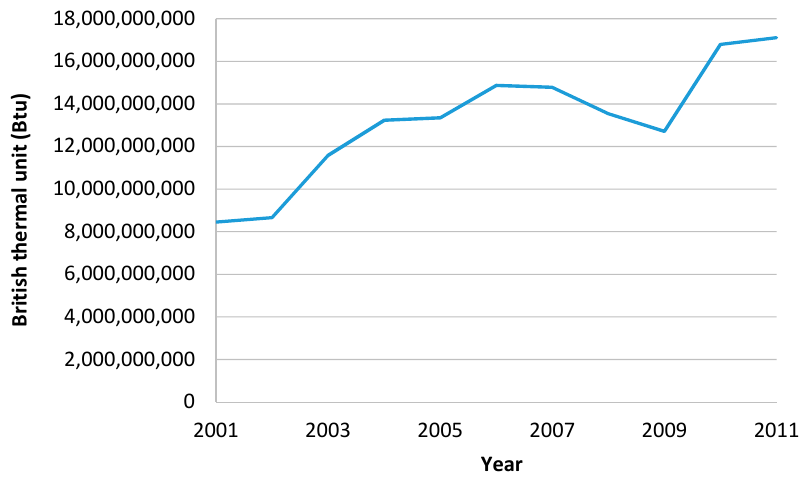
Figure 7. Natural gas used for electricity generation in Nigeria across 2001–2011 [32].